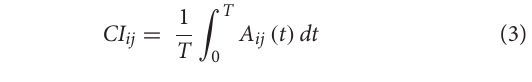
Where A ij is the overlapping area of sEMG linear envelops for length of the signal. The CI value varied from 0 (non-overlapping of the muscle pair activation in a specific movement) to 1 (the two muscles’ activation totally overlapped with both normalized sEMG activation levels kept at 1 during the movement) (36). The muscle contraction pair during cycling. Only CI values of